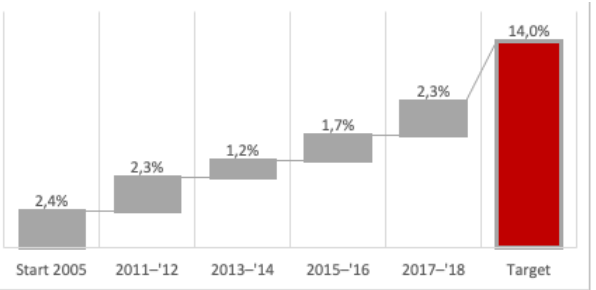
Figure 15. The Netherlands—energy consumption trend. Source: https://ec.europa.eu/eurostat/ web/energy/data/shares accessed on 28 June 2021.